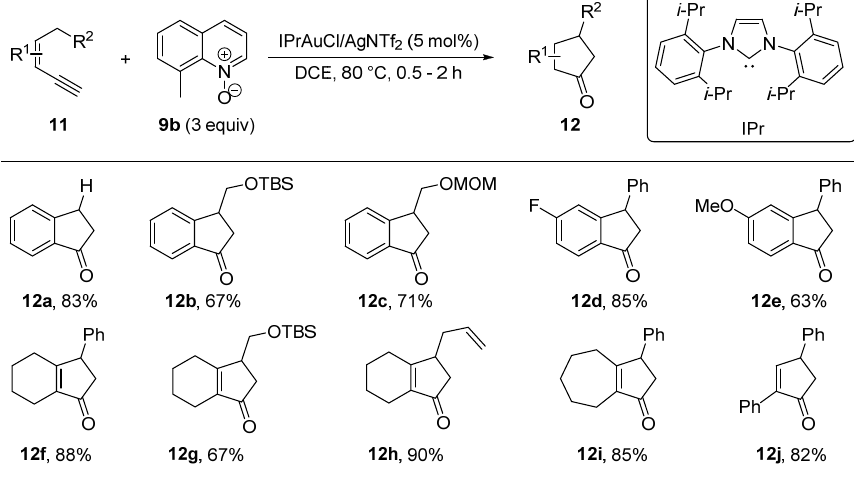
Scheme 7. Synthesis of cyclopentenone derivatives involving C–H activation 12